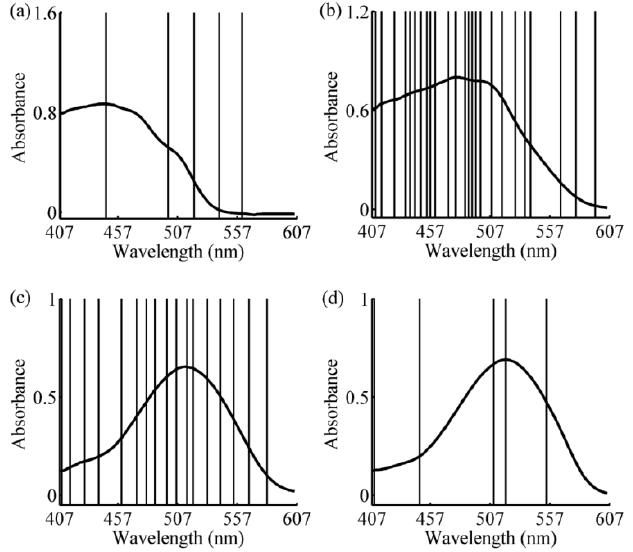
Figure 9. Wavelengths selected by simple-to-use interactive self-modeling mixture analysis. ( a ) Two-component sample 1 (tartrazine: 60 μg/mL, sunset yellow FCF: 50 μg/mL); ( b ) four-component sample (amaranth: 50 μg/mL, carmine: 60 μg/mL, tartrazine: 40 μg/mL, sunset yellow FCF: 30 μg/mL); ( c ) two-component sample 2 (amaranth: 100 μg/mL, carmine: 50 μg/mL); and ( d ) one-component sample (amaranth: 160 μg/mL).